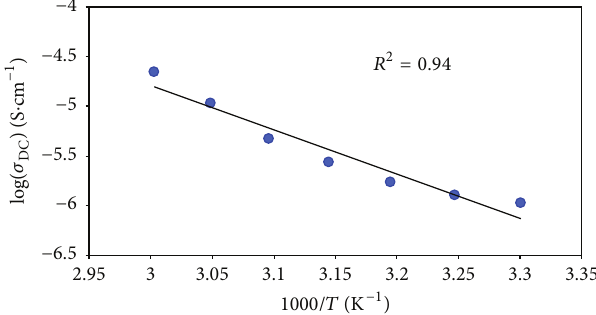
Figure 12: Dielectric constant as a function of frequency for CS: LiTf system at room temperature.